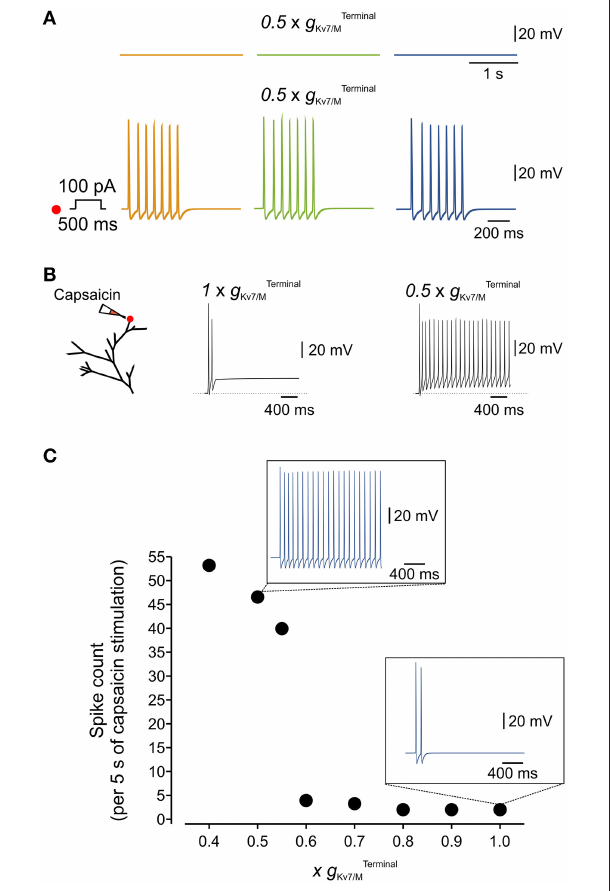
FIGURE 6 | Terminal I M controls the responsiveness of the simulated nociceptive neuron to incoming stimuli. (A) Blockade of 50% of terminal K v 7/M channels did not lead to spontaneous activation of the simulated neuron ( upper traces ) but increased its responsiveness to a 100 pA, 500ms current pulse applied to its distal terminal branch ( lower traces, compare to Figure 4B ). The location of stimulation is the same as in Figure 4 . (B) Responses to application of capsaicin-like current. Left , Scheme of the modeled terminal showing the location of capsaicin application. Middle , recording from the simulated terminal following application of capsaicin-like stimulus when g Terminal Kv7 / M is intact. Right , the same stimuli induced a substantially stronger activation of the terminal when 50% of g Terminal Kv7 / M is inhibited. (C) Graph plotting changes in number of capsaicin-like stimulus’ induced spikes (measured at the central axon during 5 sec application of capsaicin-like stimulus) with changes in g Terminal Kv7 / M (shown as a factor by which g Terminal Kv7 / M was multiplied). Inset s, Simulated recordings of changes in membrane potentials obtained from a multi-compartment model at the central axon ( blue electrode in Figure 4 ) following the same capsaicin-like stimulus (shown in (B) when g Terminal Kv7 / M intact ( lower) and reduced by half ( upper ). Note that decrease in g Terminal Kv7 / M elicited substantially stronger capsaicin-induced